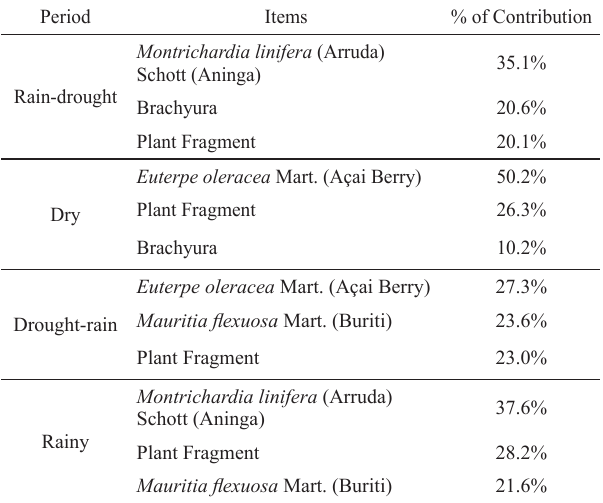
Fig. 4. Trophic niche breadth recorded for Lithodoras dorsalis on the rio Amazonas mouth, Pará, Brazil, from July 2010 to June 2011. The solid line represents the niche breadth values and the dashed line indicates mean pluviosity registered for the studied region. Table 4. Percentage contribution of the main resources consumed by Lithodoras dorsalis at Abaetetuba, south of the rio Amazonas estuary (Brazil), during the different pluviometric seasons, based on the results of the SIMPER